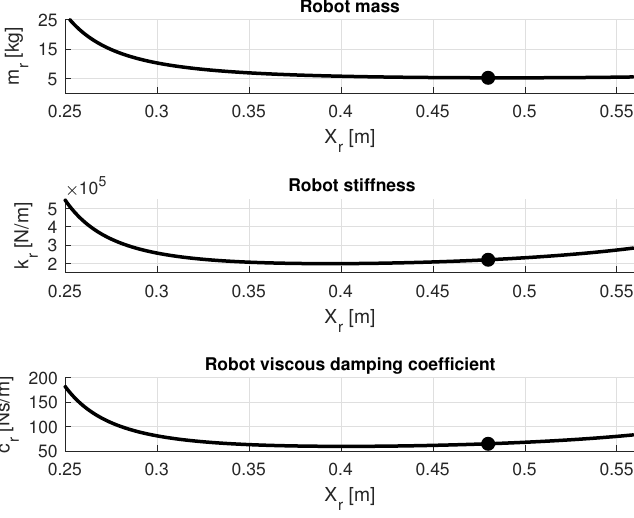
Figure 12. Lumped components m r , c r and k r as a function of the imposed position x r . The circular dot indicates the impact time.